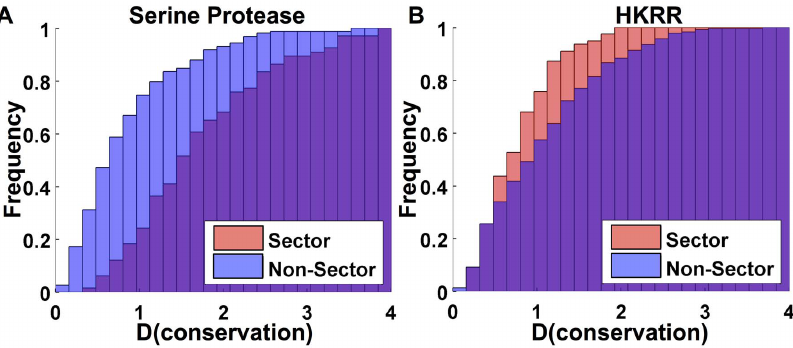
Figure 2. Amino acid conservation measured using the function D (see methods). A) Residues identified by SCA analysis of the serine protease alignment (red, labelled sector) are more conserved than the remaining residues (blue, labelled non-sector, overlap is purple). B) Residues identified by MI analysis of the HK-RR family alignment (red, labelled sector) are less conserved than the remaining residues (blue, labelled non-